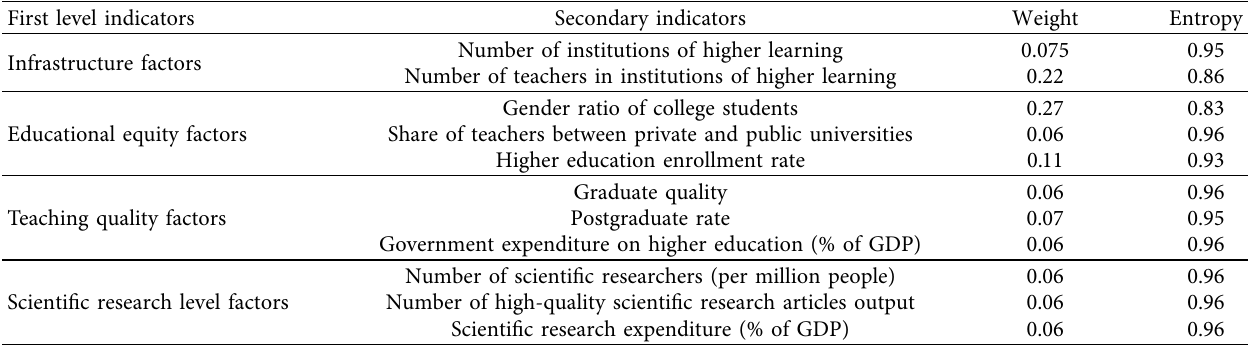
Table 2: Comprehensive evaluation results obtained by TOPSIS and the entropy weight method.